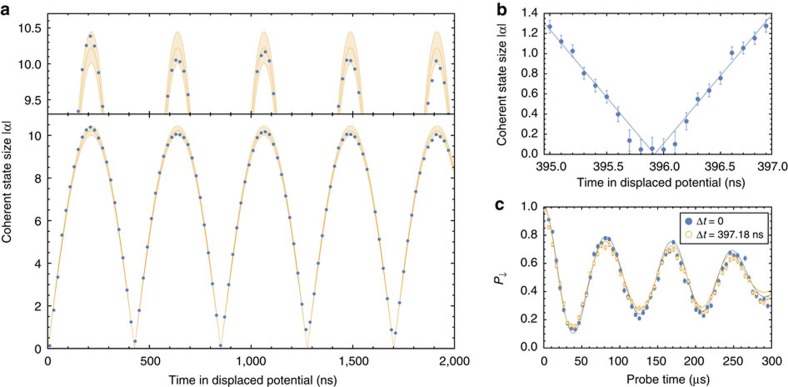
Coherent-state generation.(a) Plot of the final coherent state size |α| as a function of the evolution time Δt. The states are prepared in the original potential by executing the experimental sequence in Fig. 1c. The solid orange line is a fit to the data using equation (1). The fluctuations in amplitude can be explained by drifts in the laser power over the time taken to acquire the data (shaded area, Methods section). (b) Sub-nanosecond resolution scan around one complete motional period (Δt≈2π/ωm). This measurement was performed with ωm/(2π)≈2.53 MHz and corresponds to |α0|≈85. (c) Measured probability of finding the spin in the |↓〉 state as a function of the probe time using the s=1 sideband. Filled symbols correspond to the initially prepared state and open symbols after approximately one motional period. This measurement is independent of the previous. Here, ωm/(2π)≈2.52 MHz,  and |α0|≈85. Every data point consists of 1,000 measurements. Error bars are given as s.e.m. and assigned assuming quantum projection noise according to ref. 37.